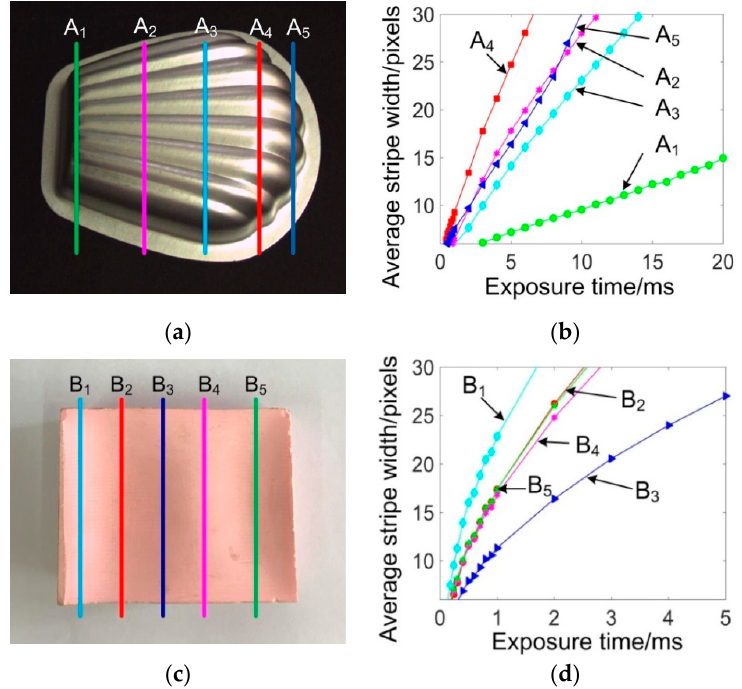
Figure 4. Relationship between the exposure time and ASW for parts at different intersection profiles. ( a ) Shiny part; ( b ) exposure time vs. ASW curves for intersection profiles of A1~A5; ( c ) matt part; ( d ) exposure time vs. ASW curves for intersection profiles of B1~B5.